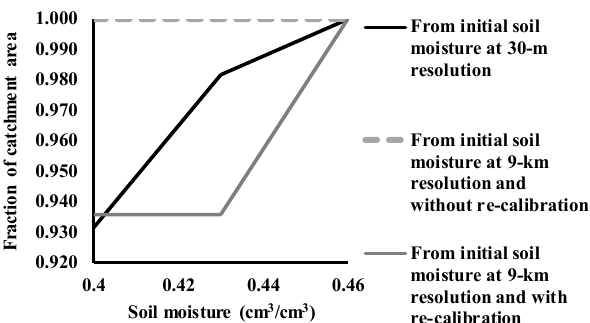
Figure 15. Cumulative distribution frequency of the simulated soil moisture state at the peak of the hydrograph.